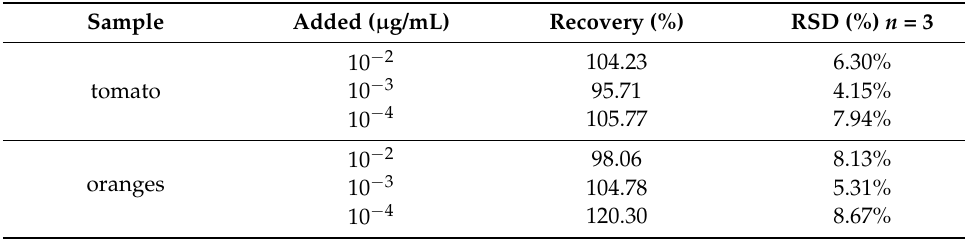
Table 3. Recovery test of TeA added to different